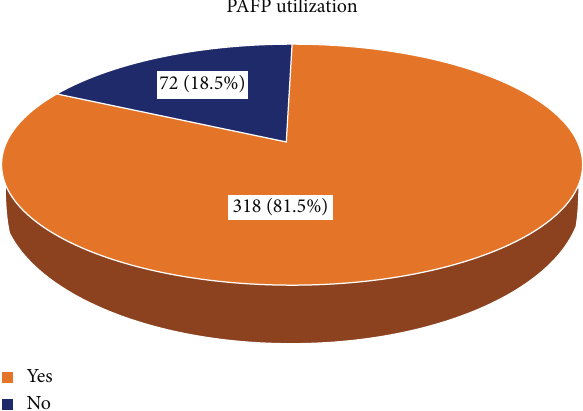
Figure 1: Magnitude of postabortion contraceptive utilization among women attending health facilities in Harar Town. Table 3: Factors associated with postabortion contraceptive utilization among women receiving abortion service in health facilities of Harar Town, Eastern